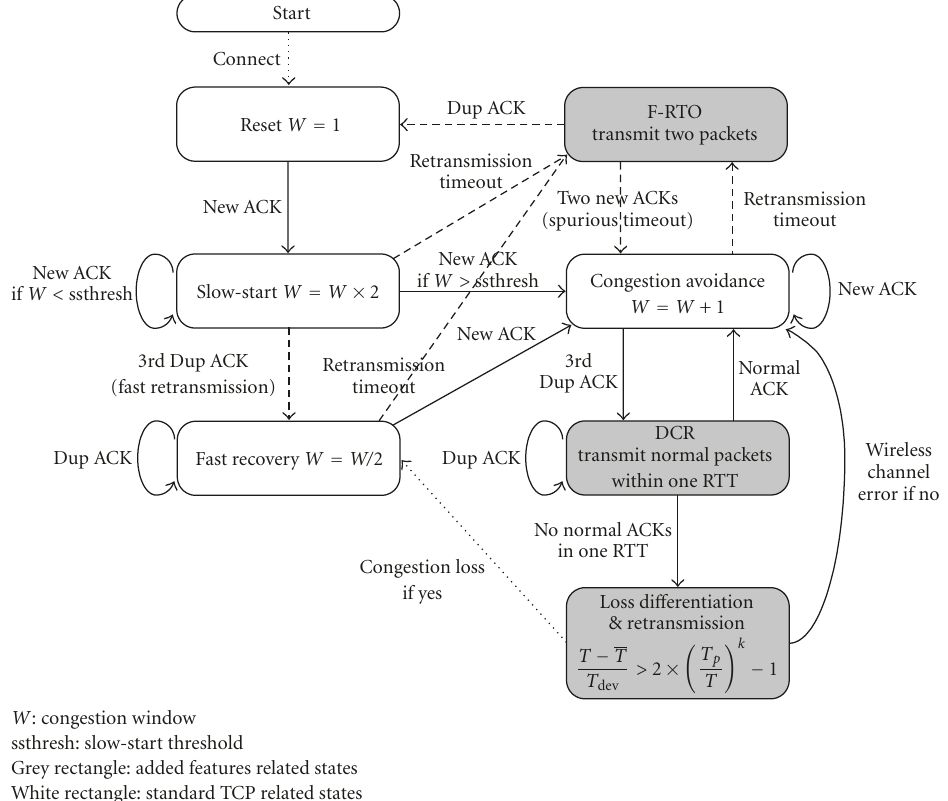
Figure 4: Proposed TCP modification in response of vertical handover. After returning congestion avoidance from F-RTO, loss di ff erentiation should not be involved by 3rd Dup ACK for n rounds.